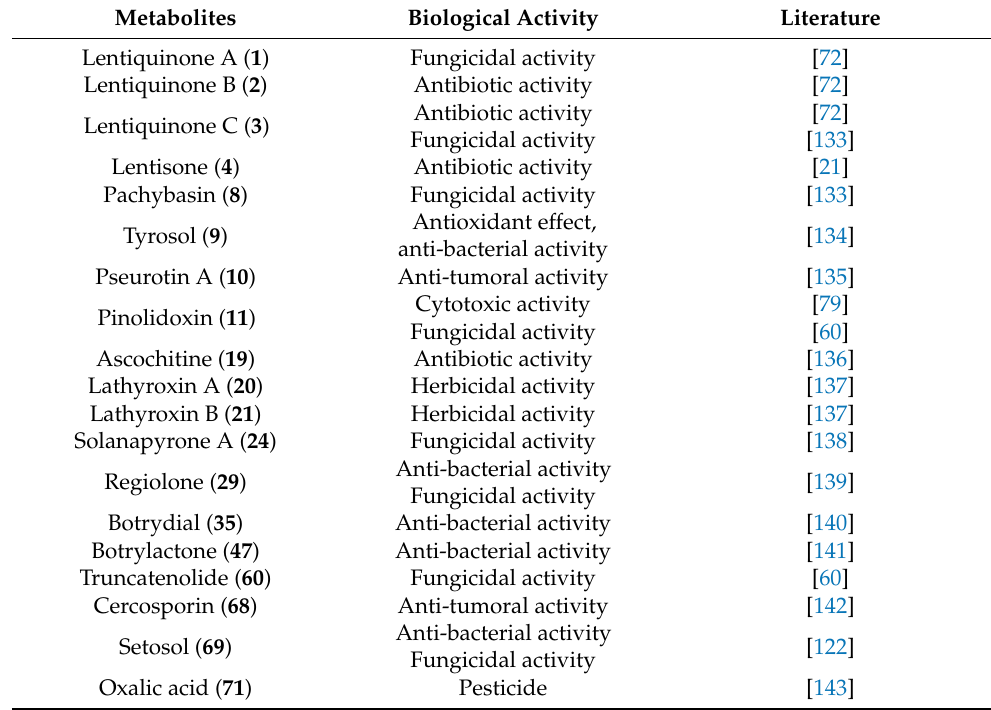
Table 2. Discovered biological activities of some of the reported phytotoxins.